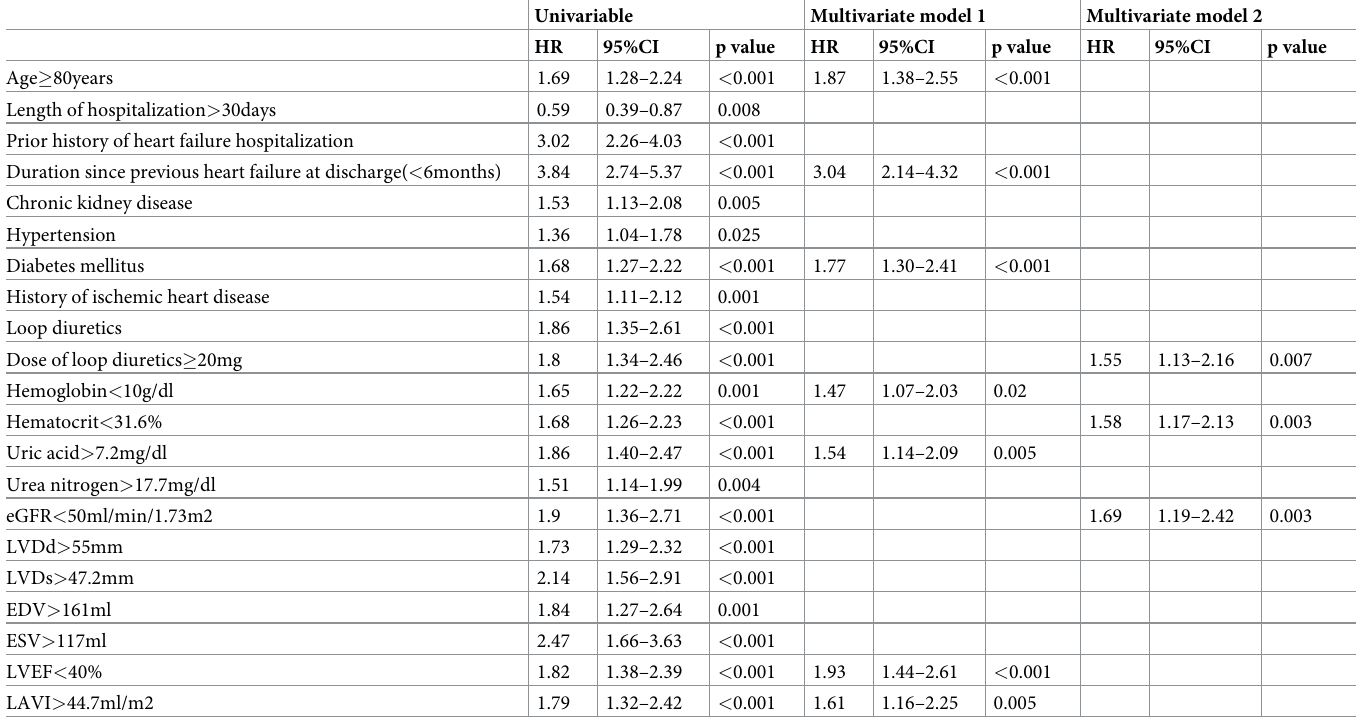
Table 2. Univariable and multivariable predictors of 1-year readmission for worsening of heart